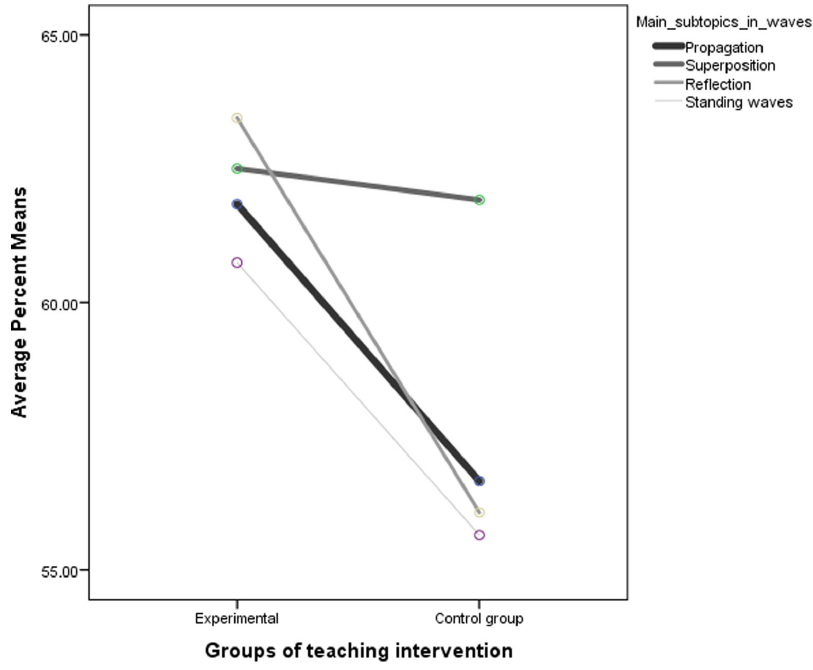
FIG. 3. Post-test performance of experimental and control group in main topics of mechanical waves.